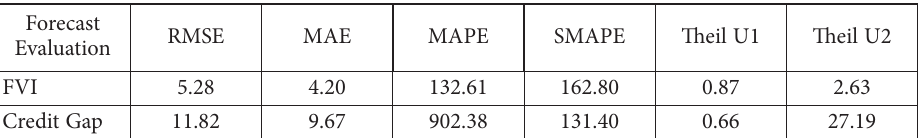
Figure 2. Contribution of indicator sub-groups Table 1. Forecast evaluation